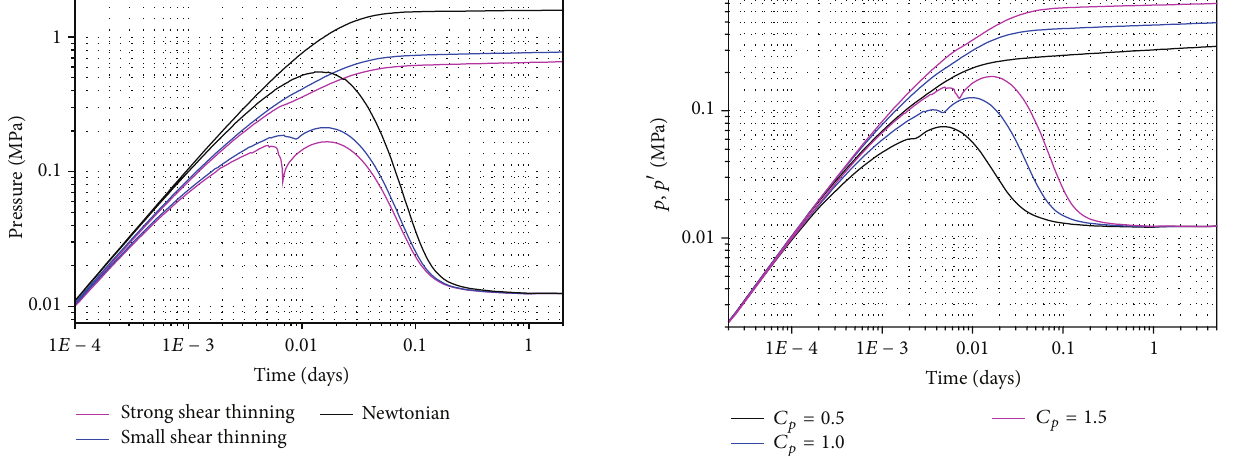
Figure 7: Log-log plot of the well bottom pressure and pressure derivative of the pressure fall-off period for various polymer con- centrations under the medium shear thinning.